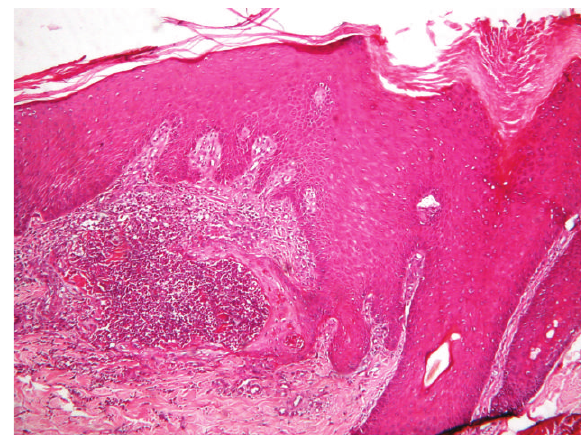
Figure 4: Histology demonstrates transepidermal elimination of necrotic material (haematoxylin and eosin, original magnification ×